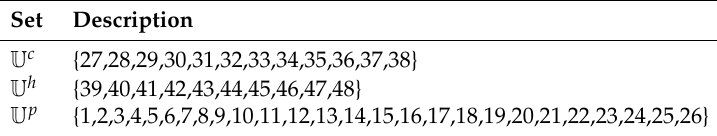
Table A9. Sets used test instance